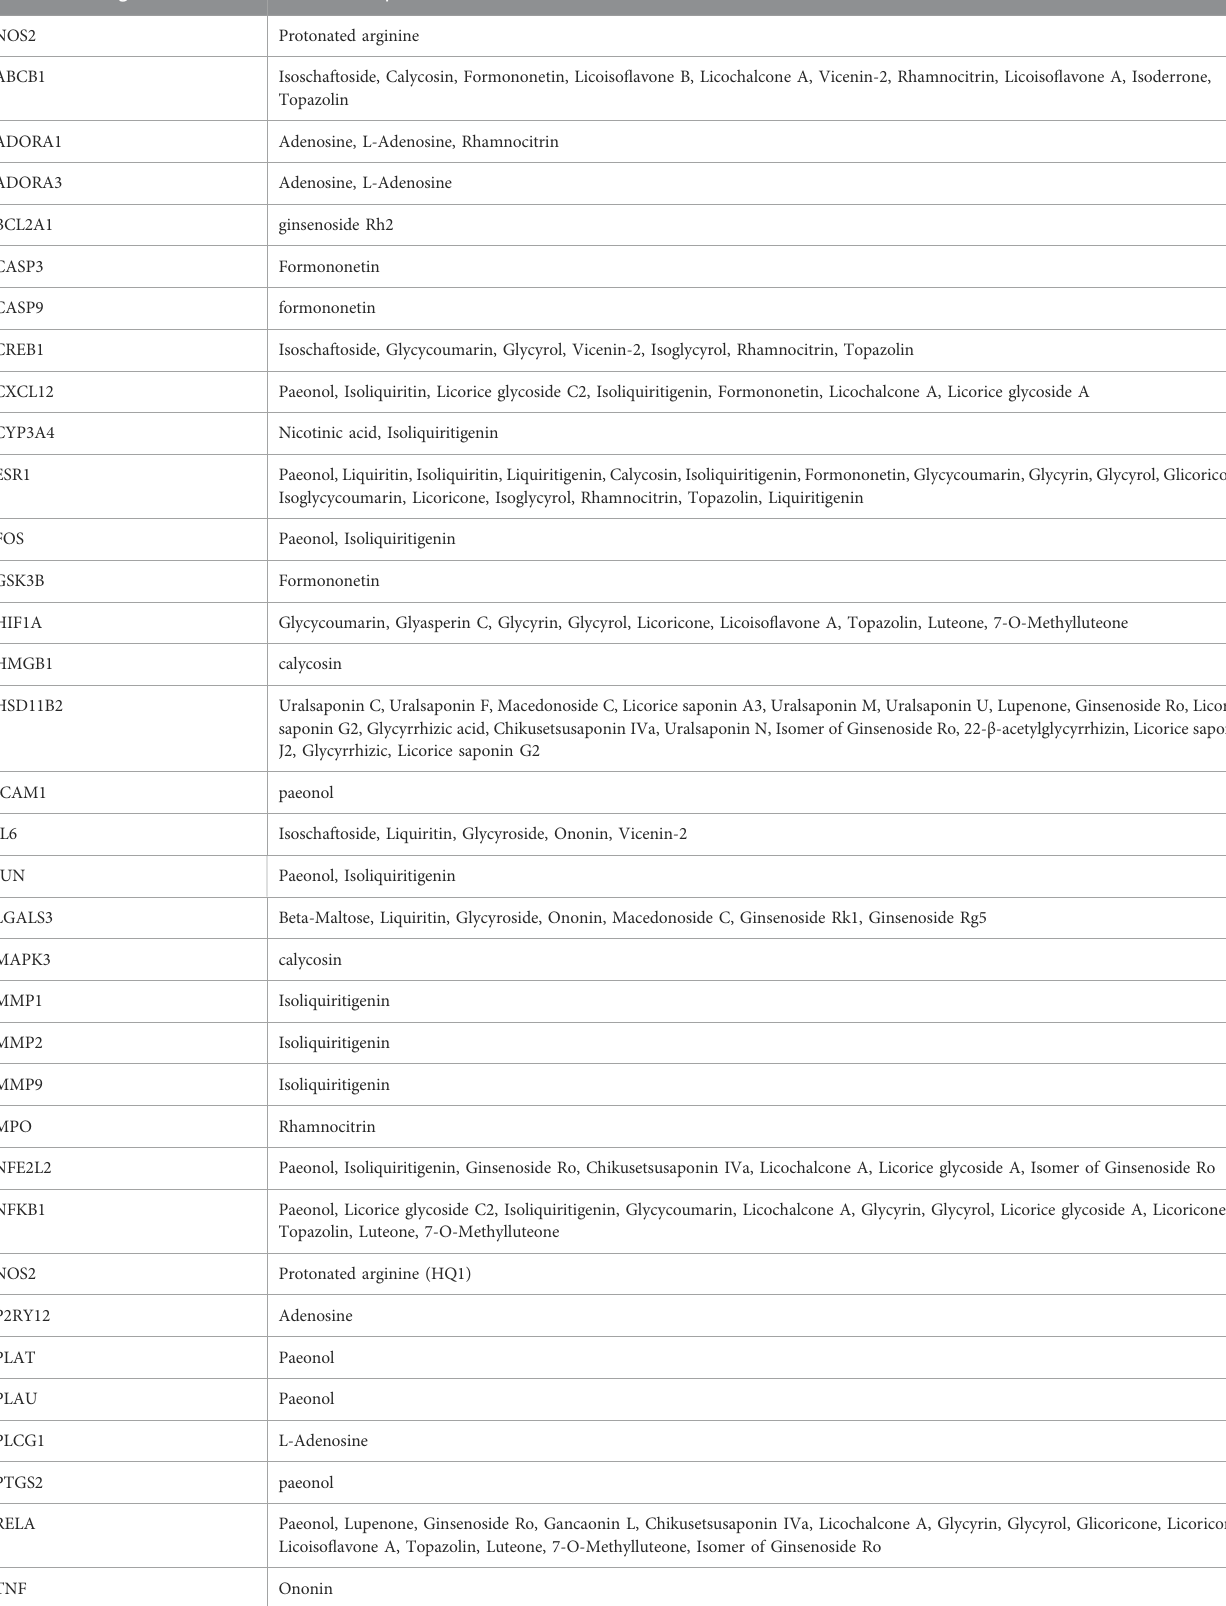
TABLE 2 Molecular targets for the active compounds from BYDE. Molecular targets Active compounds from